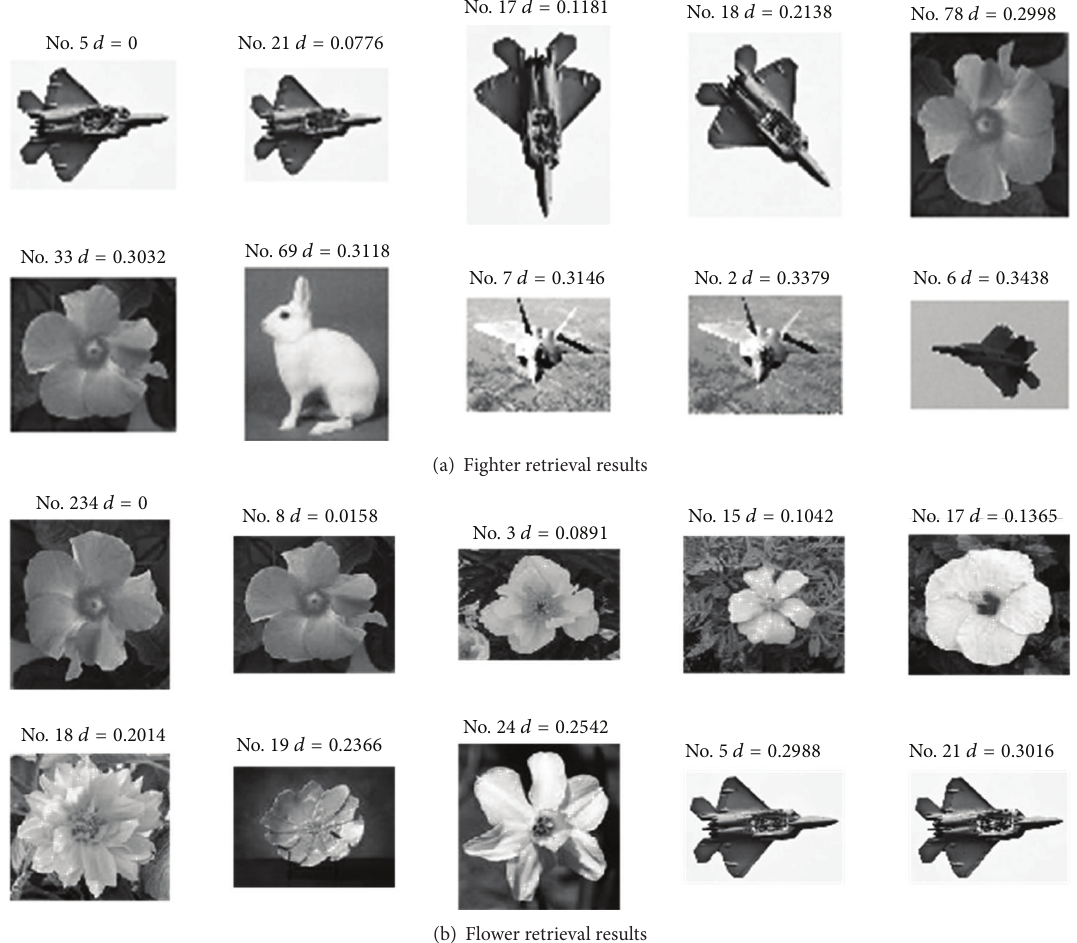
Figure 7: Retrieval results for